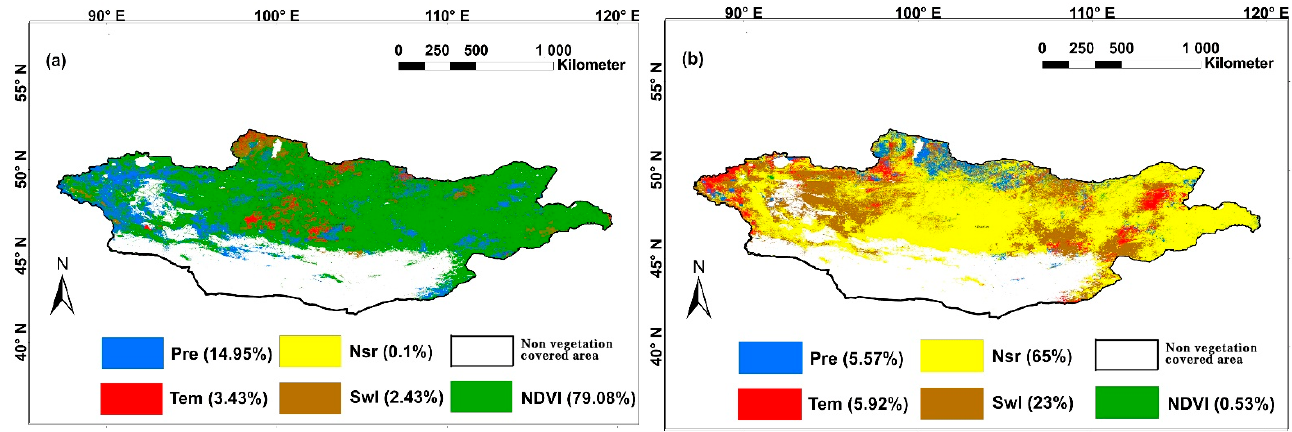
Figure 8. Spatial distributions of the dominant climate factors in the growing season from 2001 to 2020: ( a ) dominant factors positively correlated with ET; ( b ) dominant factors negatively correlated with ET.